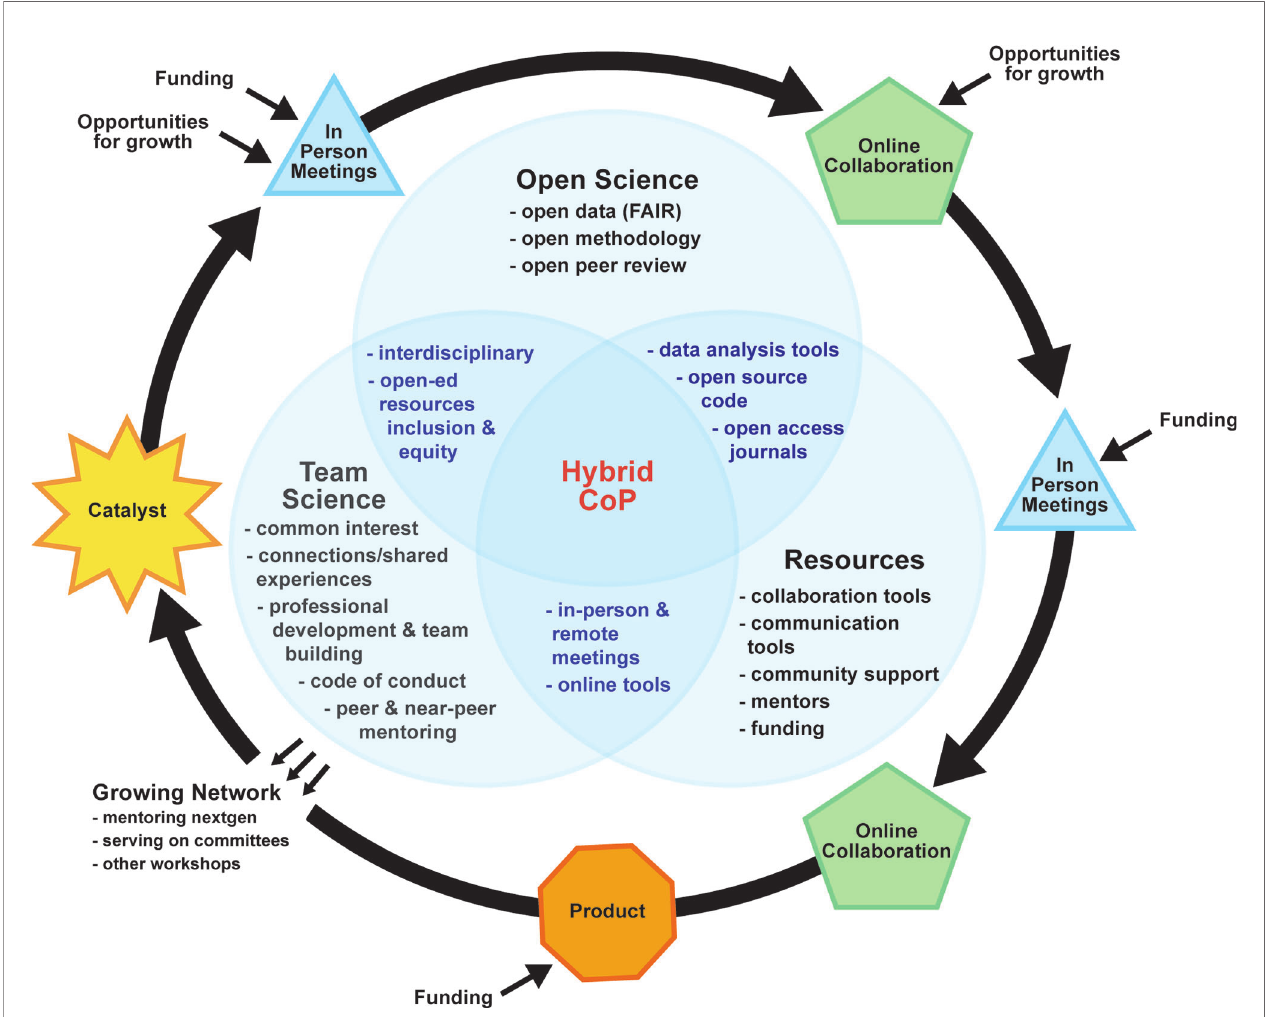
FIGURE 1 | Schematic of Hybrid Community of Practice Model. Core components of the model outlined in the text are in the Venn Diagram. The black arrows surrounding the Venn Diagram represent time. The model “ starts ” at the “ Catalyst ” marker, where the “ Catalyst ” is an idea or common interest. Next is the “ In-person Meeting ” , which is an “ Opportunity for growth ” and “ Funding ” is needed for this meeting. After the meeting passes, online collaboration picks up and that is how the group moves forward until the next in-person gathering. Eventually a “ Product ” as a result of collaborating is produced (i.e. manuscript, conference presentation) and a result of this product is the “ Growing of the Network ” as others see the product. As the network grows, the group ’ s service also grows towards the other group members and the cycle restarts with other ideas/interests with the new